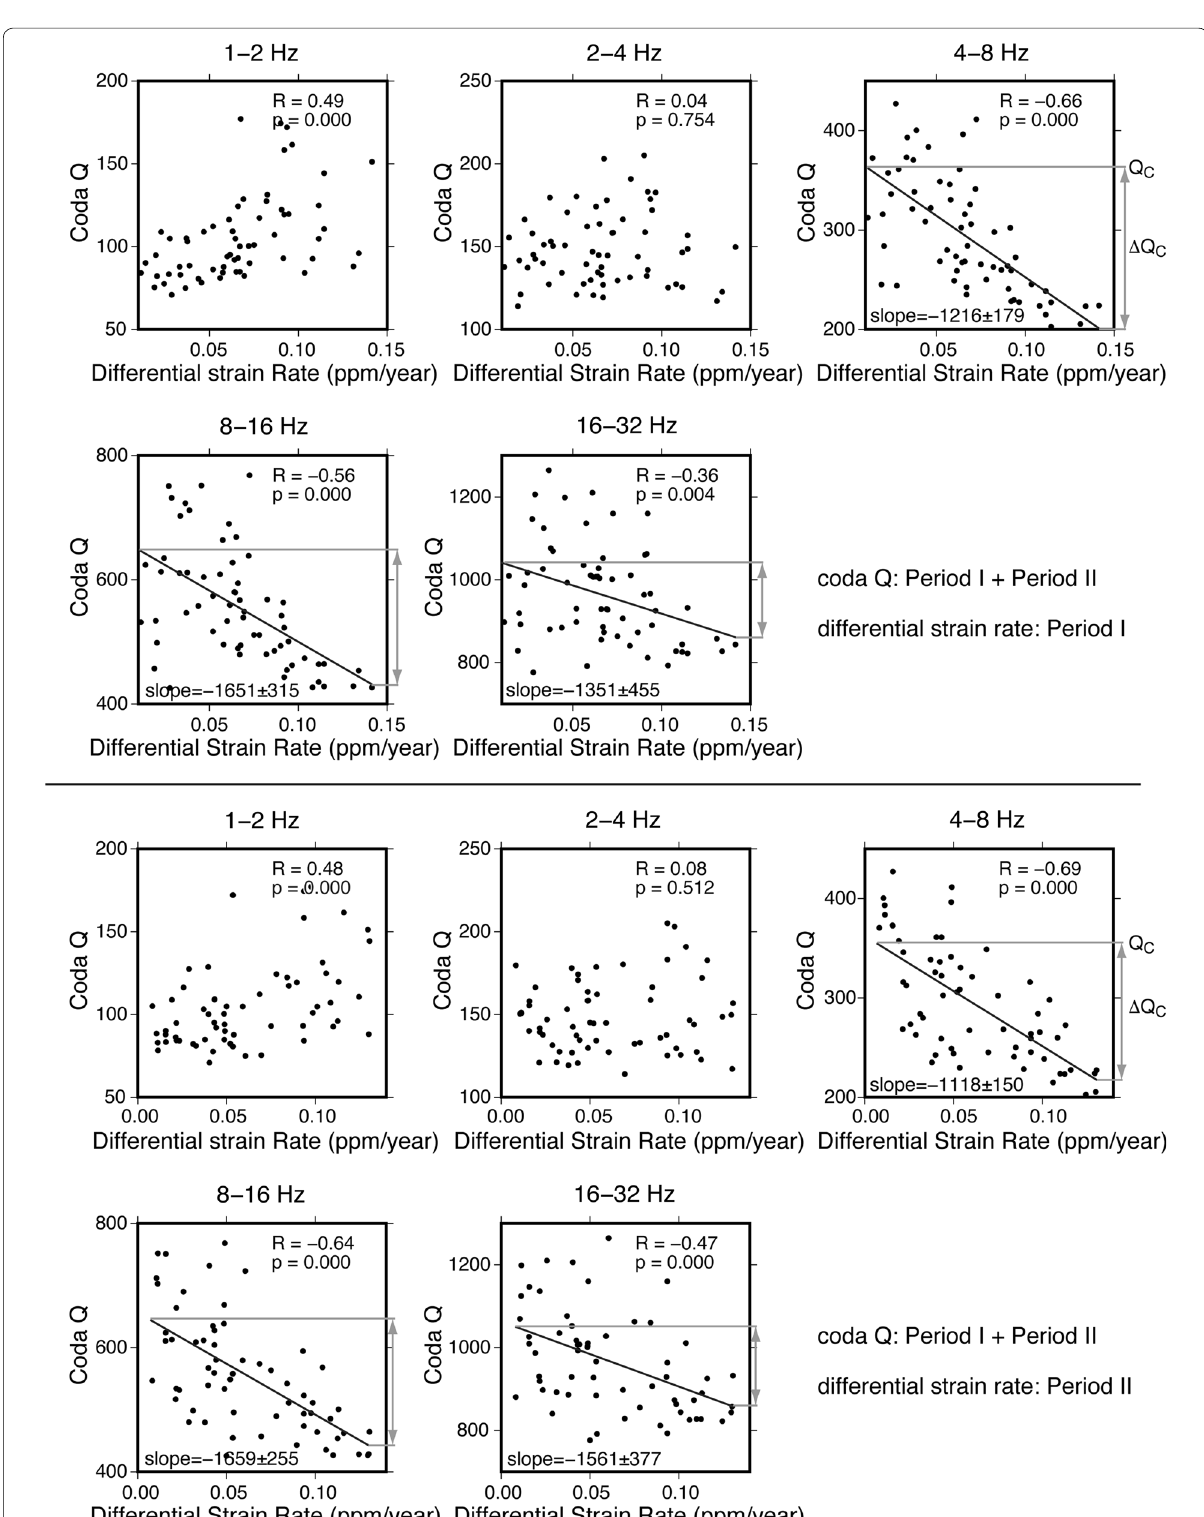
Fig. 8 Upper panels: plots of differential strain rate in the period I versus coda Q at five frequency bands in the periods I and II. Lower panels: plots of differential strain rate in the period II versus coda Q at five frequency bands in the periods I and II. Black line is the least square fit to the plot. Gray lines represent the definition of Δ Q C and Q